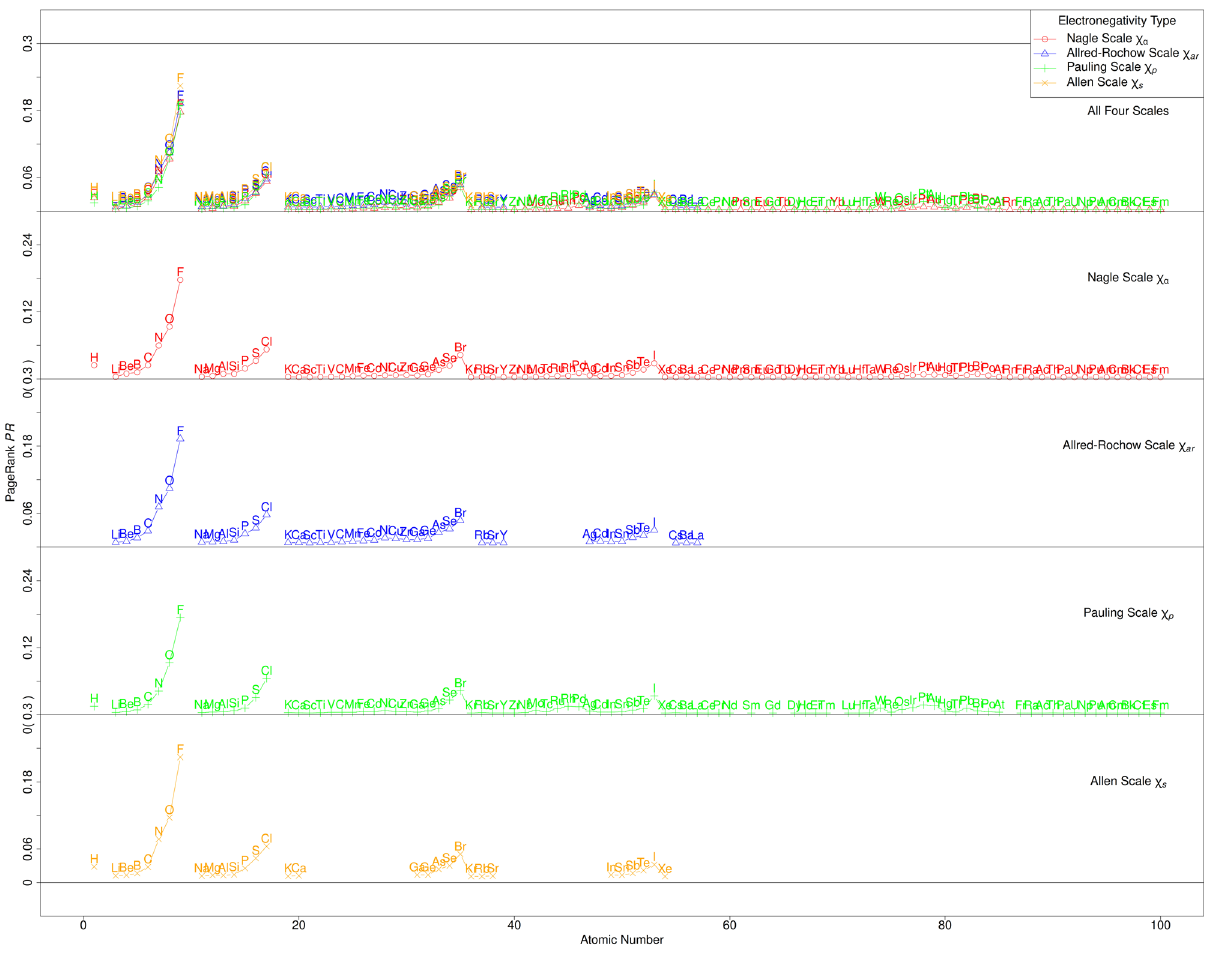
Figure 8: PR changing trends in the four DCBNs.